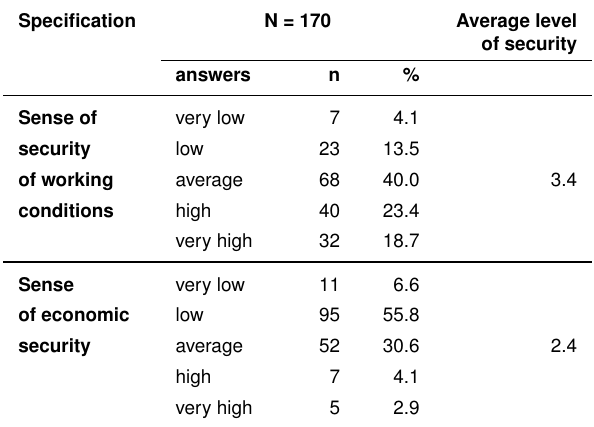
Table 2. Evaluation of the level of employee security under the conditions of the Covid-19 pandemic (N =